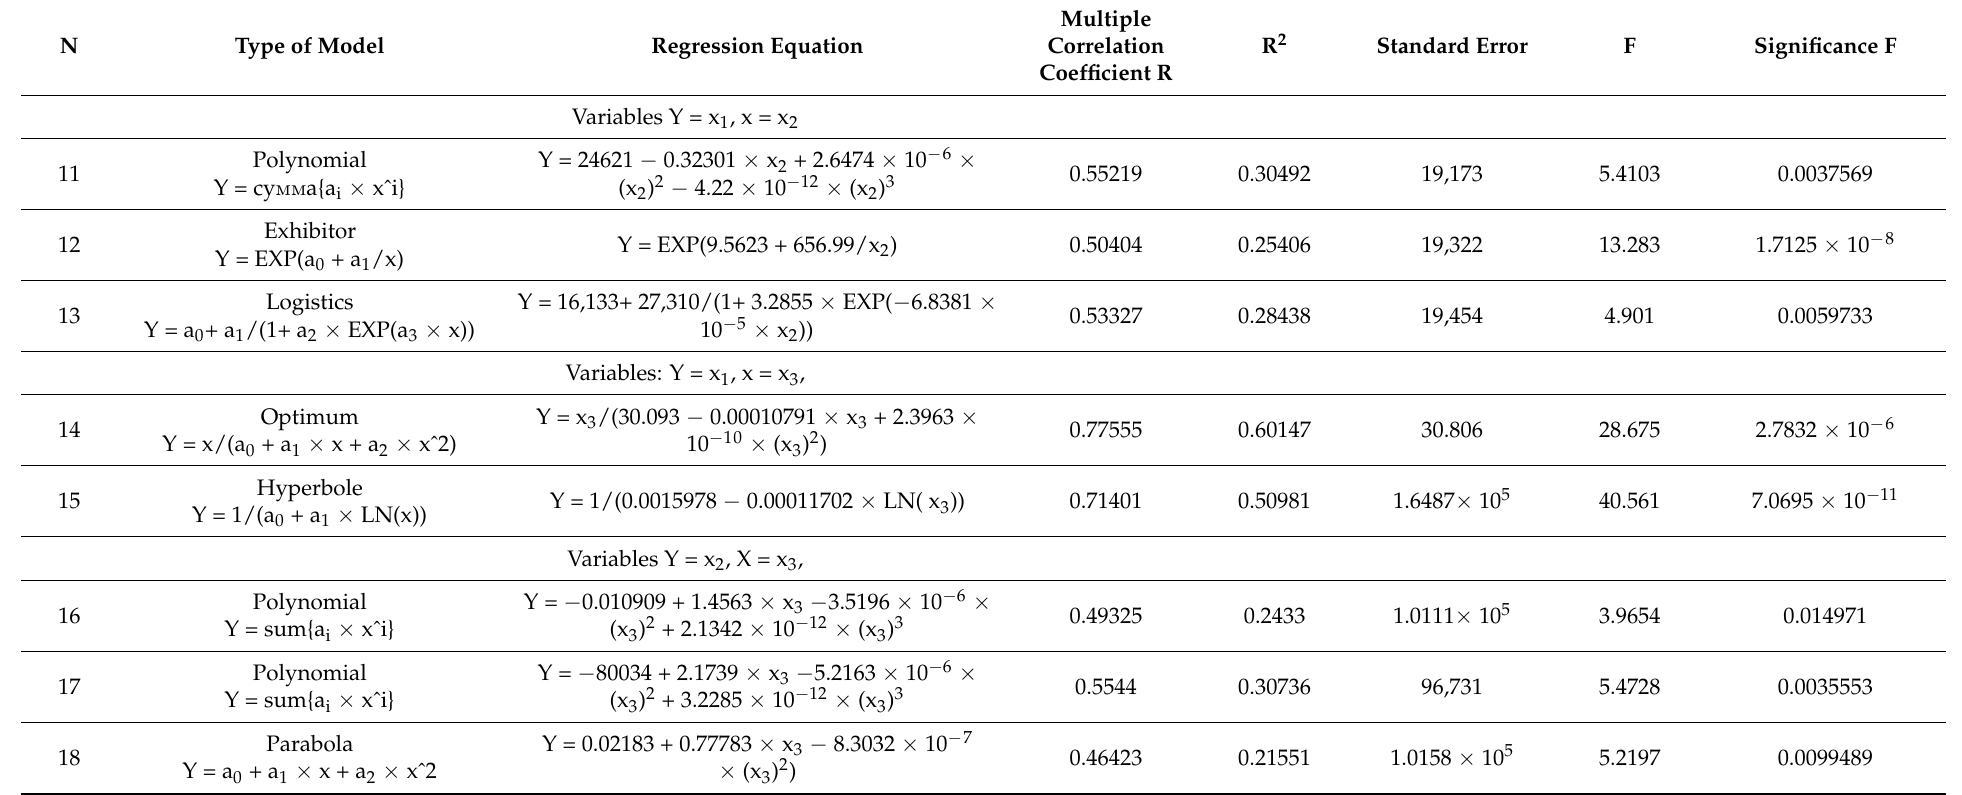
Table 2. Results of the regression analysis of the variables of the second cluster